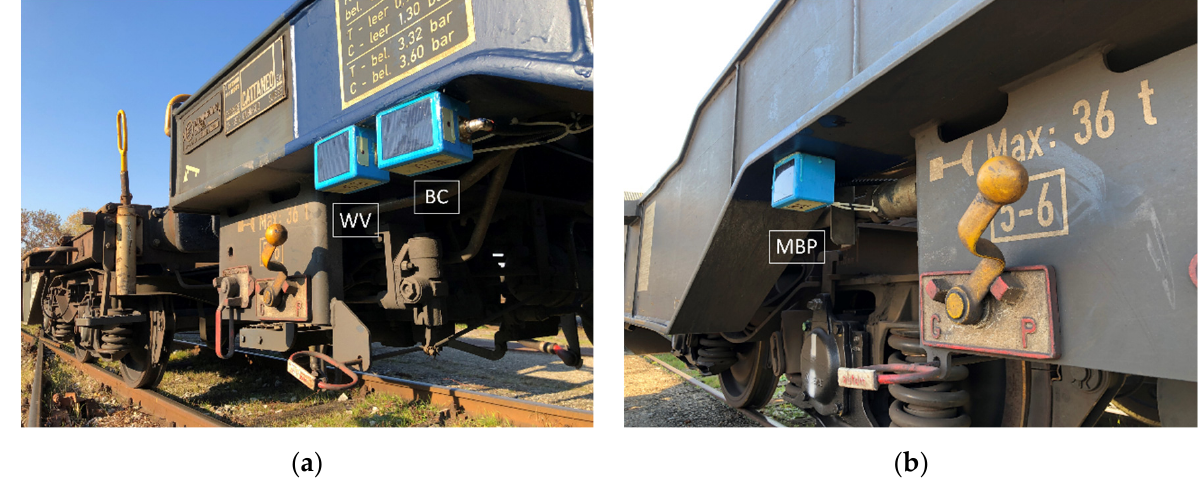
Figure 9. Position of sensor nodes on Mercitalia Intermodal wagon (Figure 7). ( a ) Node BC and WV ( b ) Node MBP.